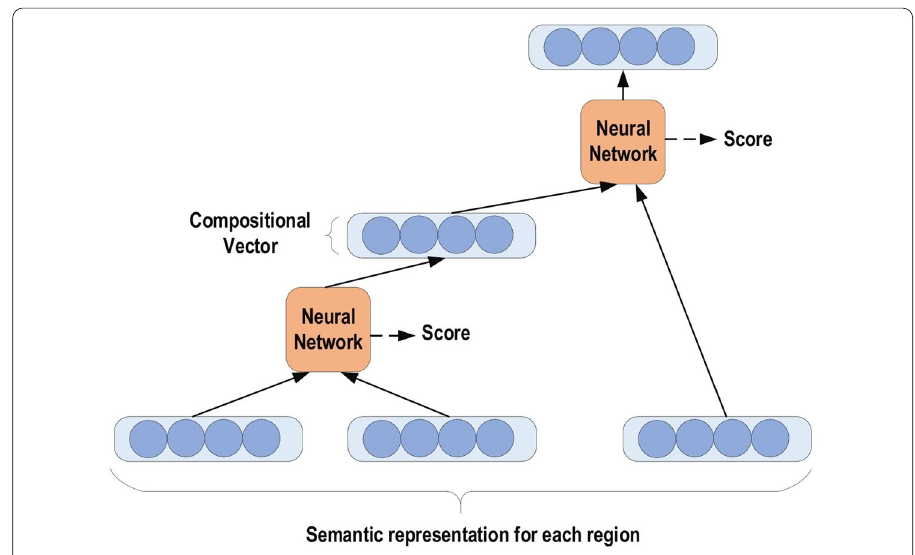
Fig. 5 An example of RvNN